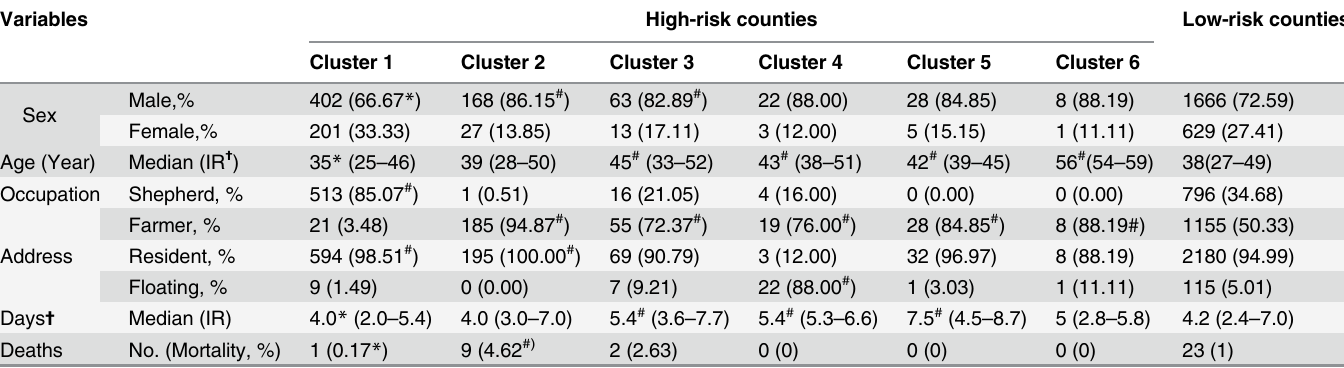
* Signi fi cant difference with lower value in high-risk counties compared with low-risk counties ( χ 2 test, Fisher ’ s exact test or Z test with p < 0.05) # Signi fi cant difference with higher value in high-risk counties compared with low-risk counties ( χ 2 test or Z test with p < 0.05) ✝ Interquartile range ✝ Days from illness onset to